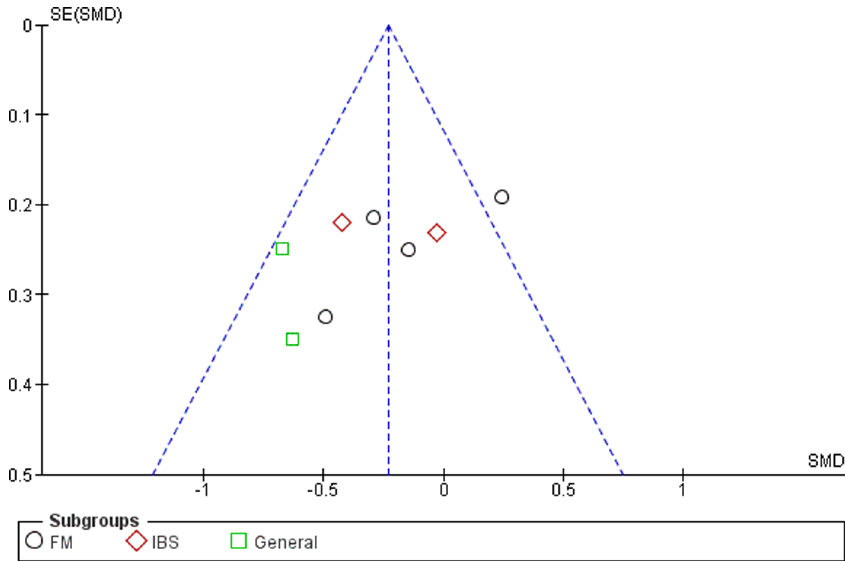
Figure 5. Funnel plot for depression.